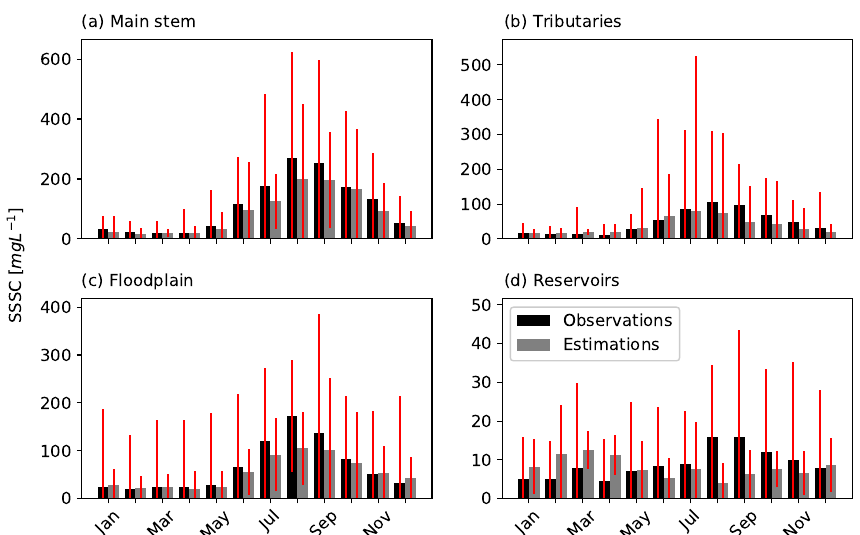
Figure 6. Monthly median estimates of SSSC from 1985–2011 against observed monthly median SCC for the 44 water quality stations used in this study. The stations were classified into four groups: ( a ) mainstem of Mekong river; ( b ) tributary river systems; ( c ) the Mekong floodplain region and ( d ) reservoirs. Red bars indicate the standard deviation of each month from all stations in the group.